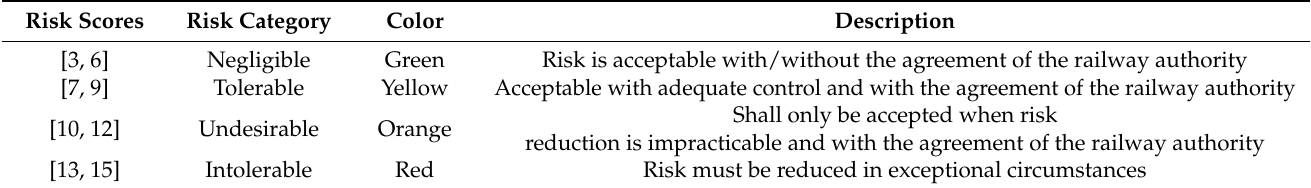
Table 6. Risk acceptance criteria of the transportation